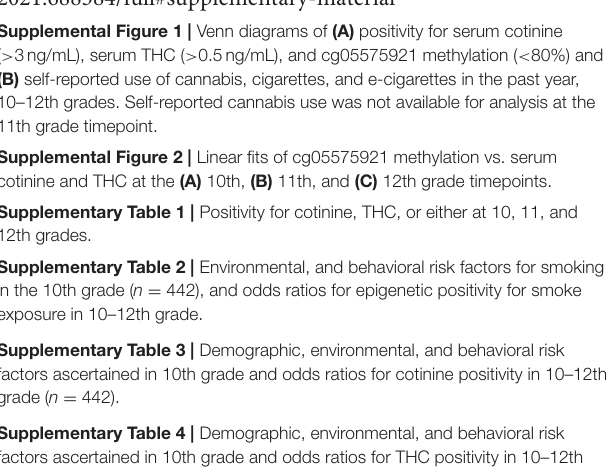
Supplementary Table 4 | Demographic, environmental, and behavioral risk factors ascertained in 10th grade and odds ratios for THC positivity in 10–12th grade ( n =